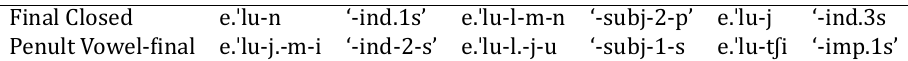
Table 21: Stage I stem-stress on a (cid:976)inal closed syllable and on a penultimate syllable in a vowel-(cid:976)inal verb (example: [elu-]